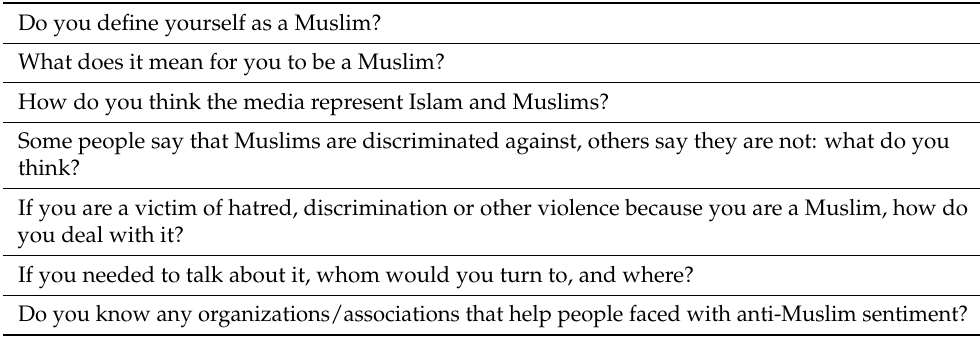
Table 2. Core interview questions